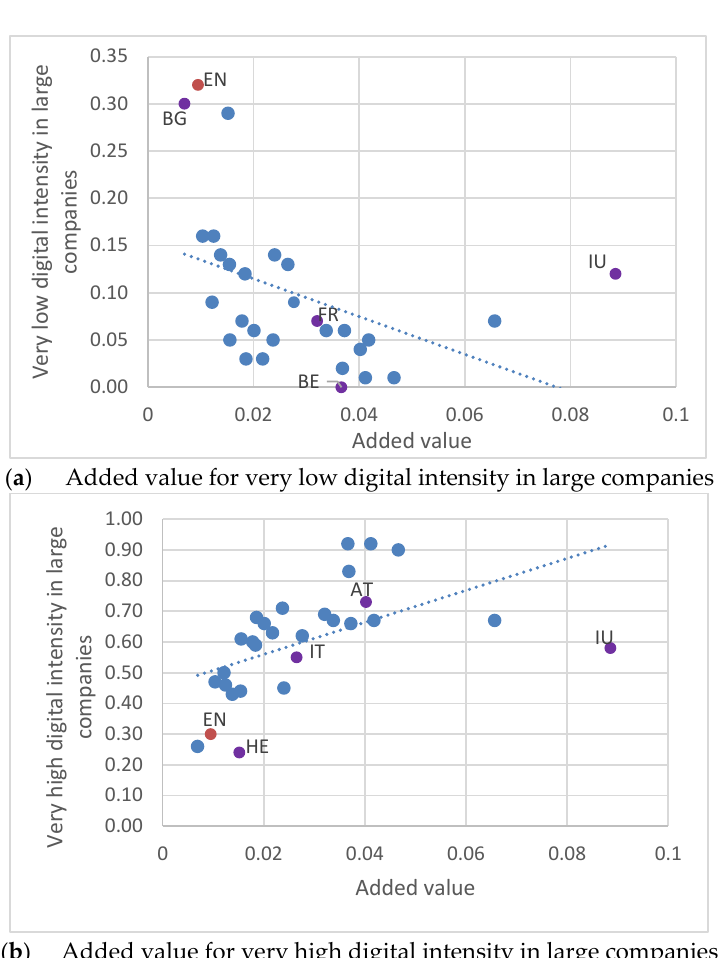
Figure 6. The relationship between digital intensity in large companies and added value in the EU in 2019.